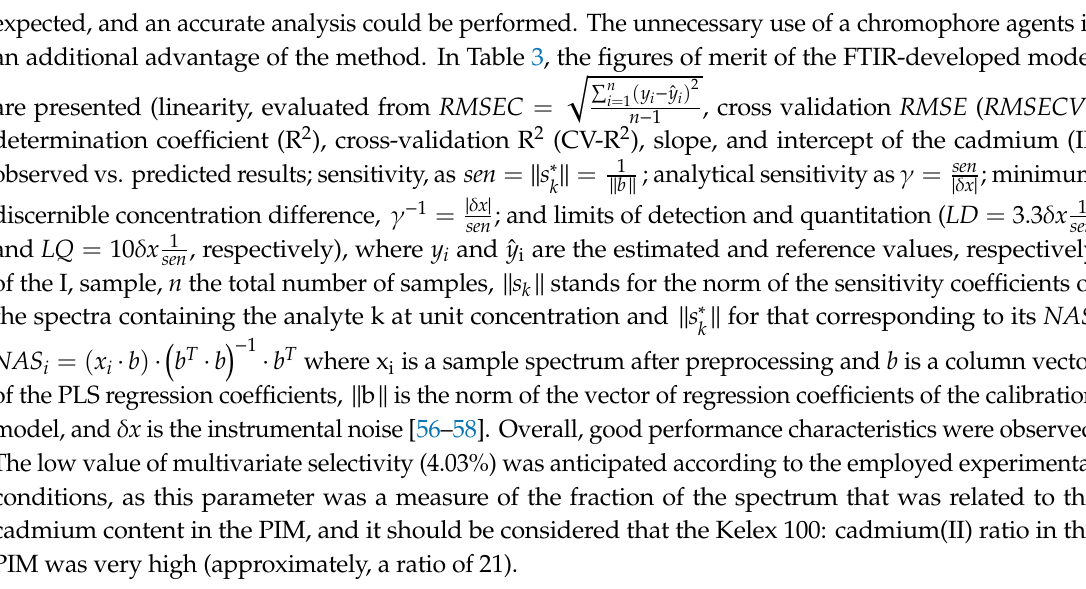
Table 3. Analytical figures of merit for the developed MID-FTIR method. Figure of